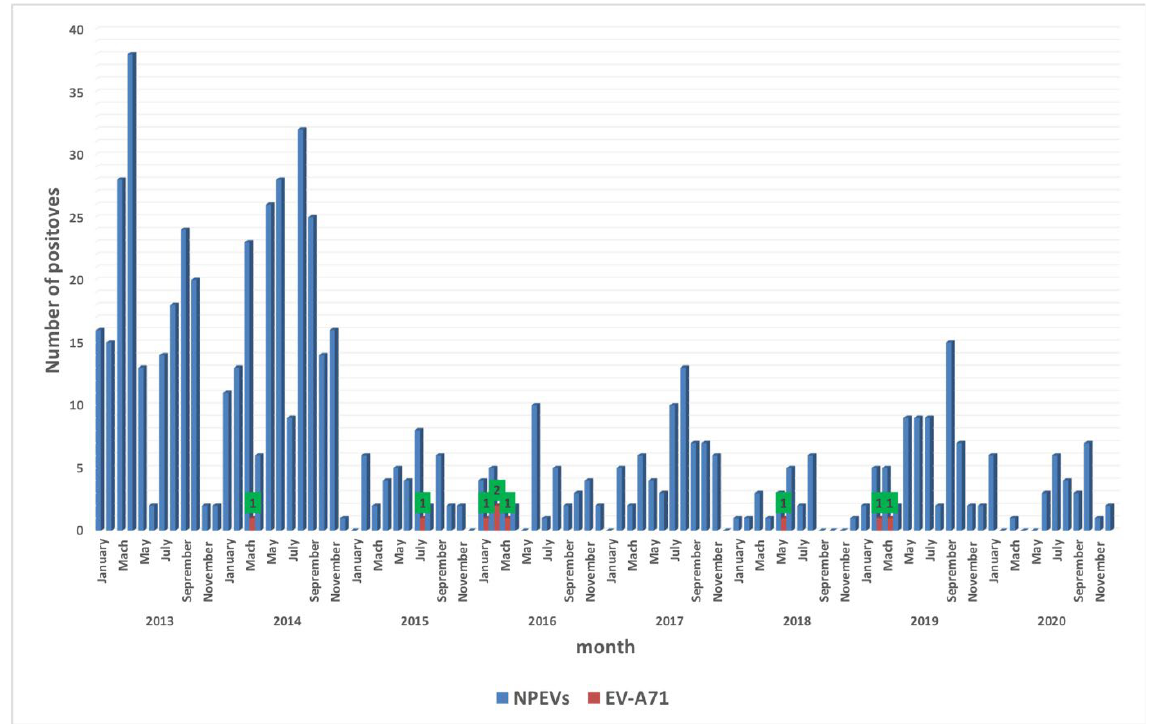
Figure 1. Monthly distribution of NPEV and EV-A71 identified in Senegal from 2013 to 2020. The shaded bars show positive specimens from patients for NPEV (in blue) and EV-A71 (in red). The green boxes with numbers (1 or 2) indicate the number of EV-A71-positive isolates.